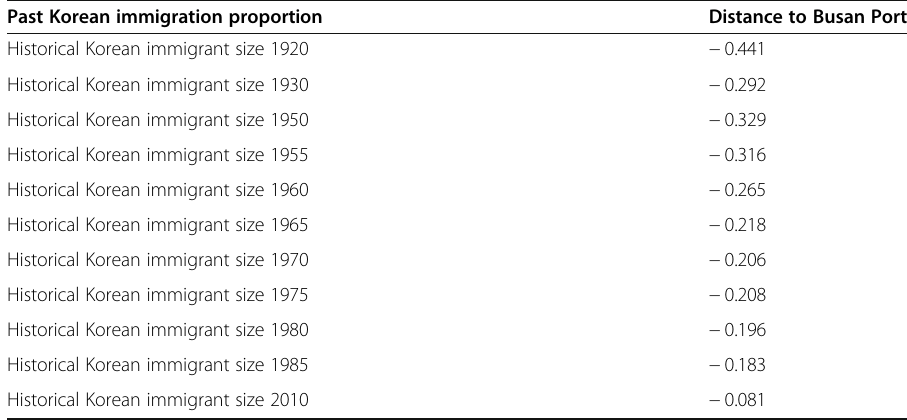
Table 7 Correlation between past Korean immigration and distance to Busan Port Past Korean immigration proportion